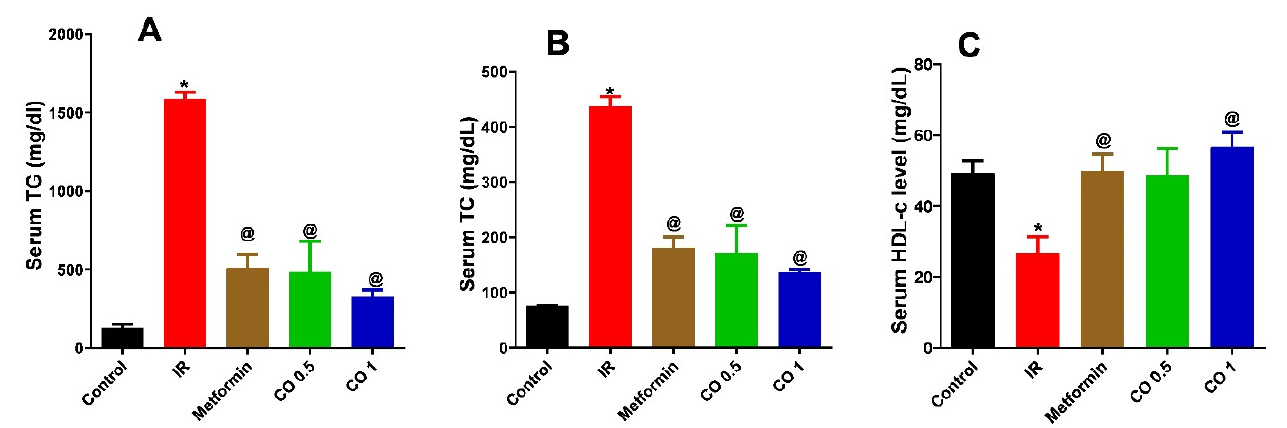
Figure 5. Effect of coriander oil (CO, 0.5 and 1 mL/kg, PO) and metformin (50 mg/kg/day, PO) on serum triglycerides (TG) ( A ) serum total cholesterol (TC) ( B ) and serum high density lipoprotein (HDL) ( C ) in dexamethasone-induced insulin resistance in rats (IR). Results were analyzed by one- way ANOVA followed by the Post-hoc Tukey test. Results are shown in mean ± SEM ( n = 6). * , @ p < 0.05 compared to normal, and IR groups, respectively.